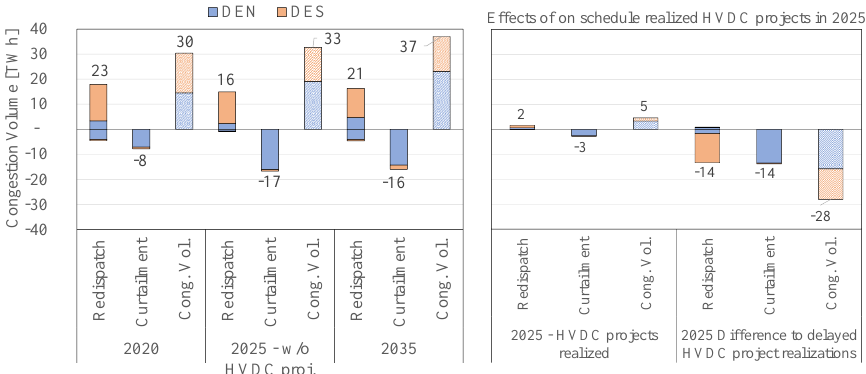
Figure 8. Congestion volumes for Germany in the REF case.